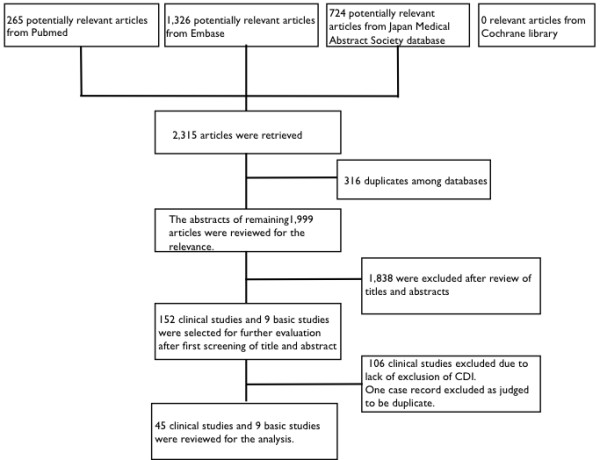
Study selection.